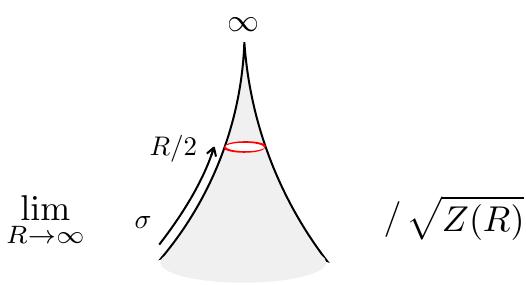
Figure 8 . We regularize the operator insertion on a planar surface by cutting o(cid:11) the cone around the puncture or, pictorially, by pulling the state o(cid:11) the tip and placing it at the position (cid:27) = R= 2 (cid:29) 1 along the mirror spatial direction (cid:27) . The renormalized operator insertion is de(cid:12)ned as the quotient of the regularized operator by the square root of the excited state partition function Z ( R ), in the limit where the cut o(cid:11) R is sent to in(cid:12)nity. This procedure remove the local divergences